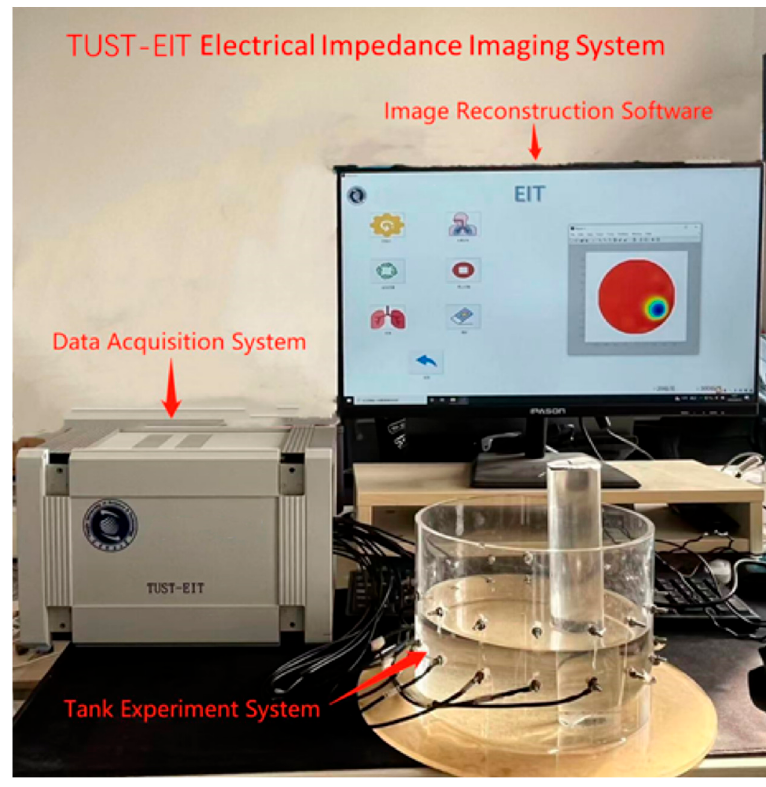
Figure 3. TUST-EIT Electrical Impedance Imaging System.